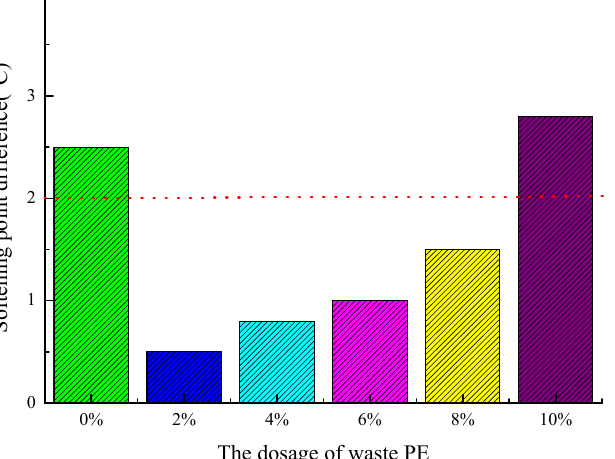
Figure 9. Softening point difference of waste plastic/rubber-modified asphalt at various dosages of waste polyethylene (PE).